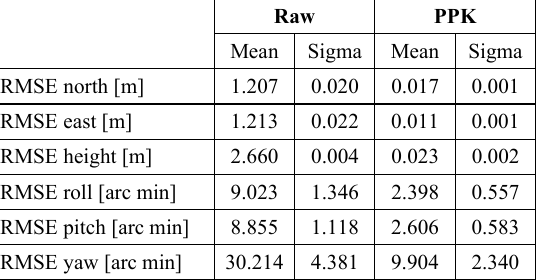
Table 2: Performance metrics for real-time reference frame (raw) and post-processed smoothed best estimated trajectory